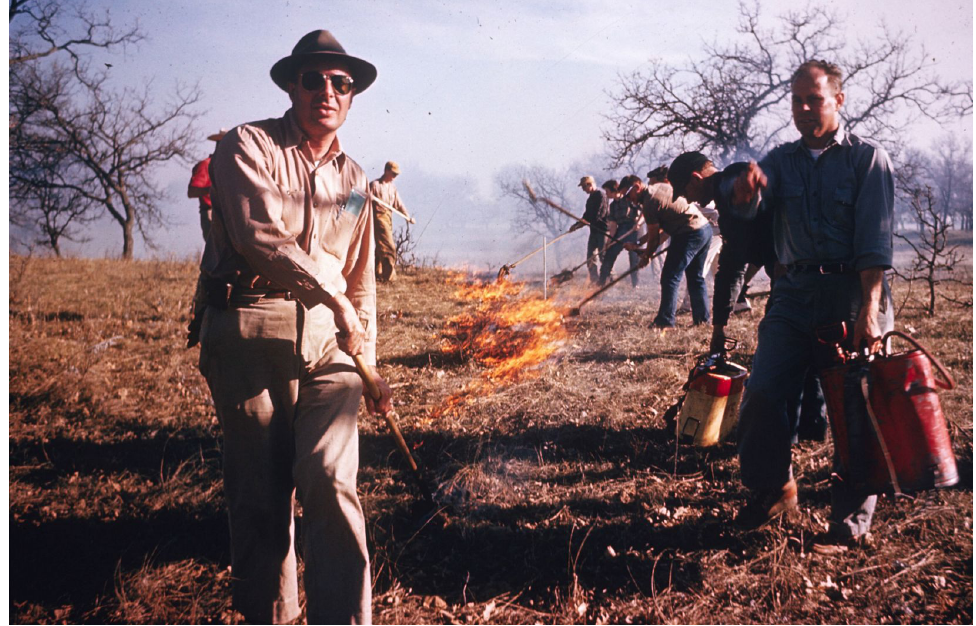
Figure 2. The Nature Conservancy conducted its first prescribed fire at the Helen Allison Scientific and Natural Area, Minnesota, in